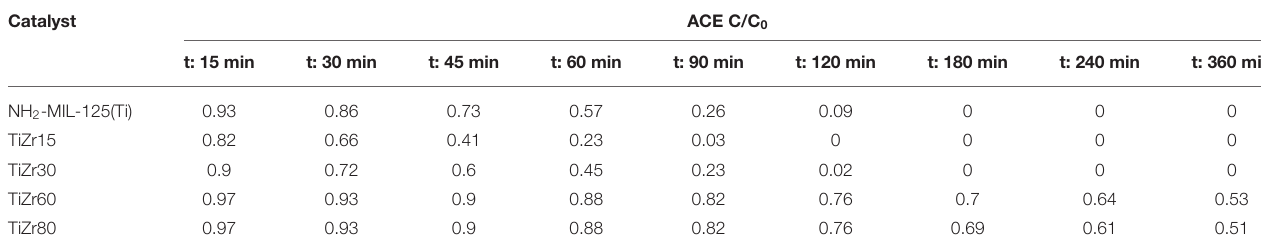
TABLE 9 | Acetaminophen (ACE) photodegradation using different catalysts. Catalyst ACE C/C